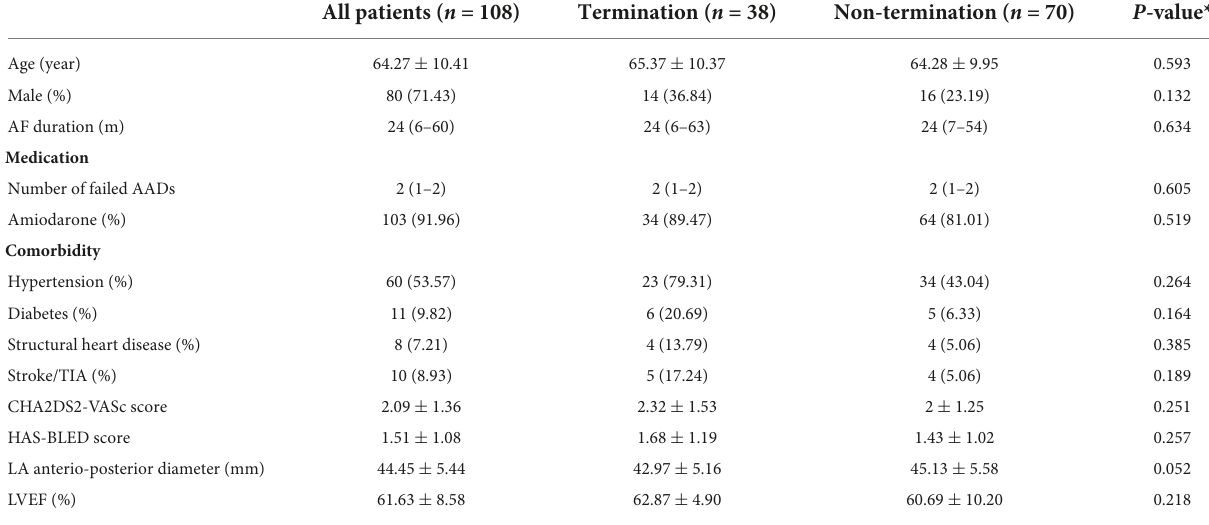
TABLE 1 Baseline characteristics of enrolled subjects.